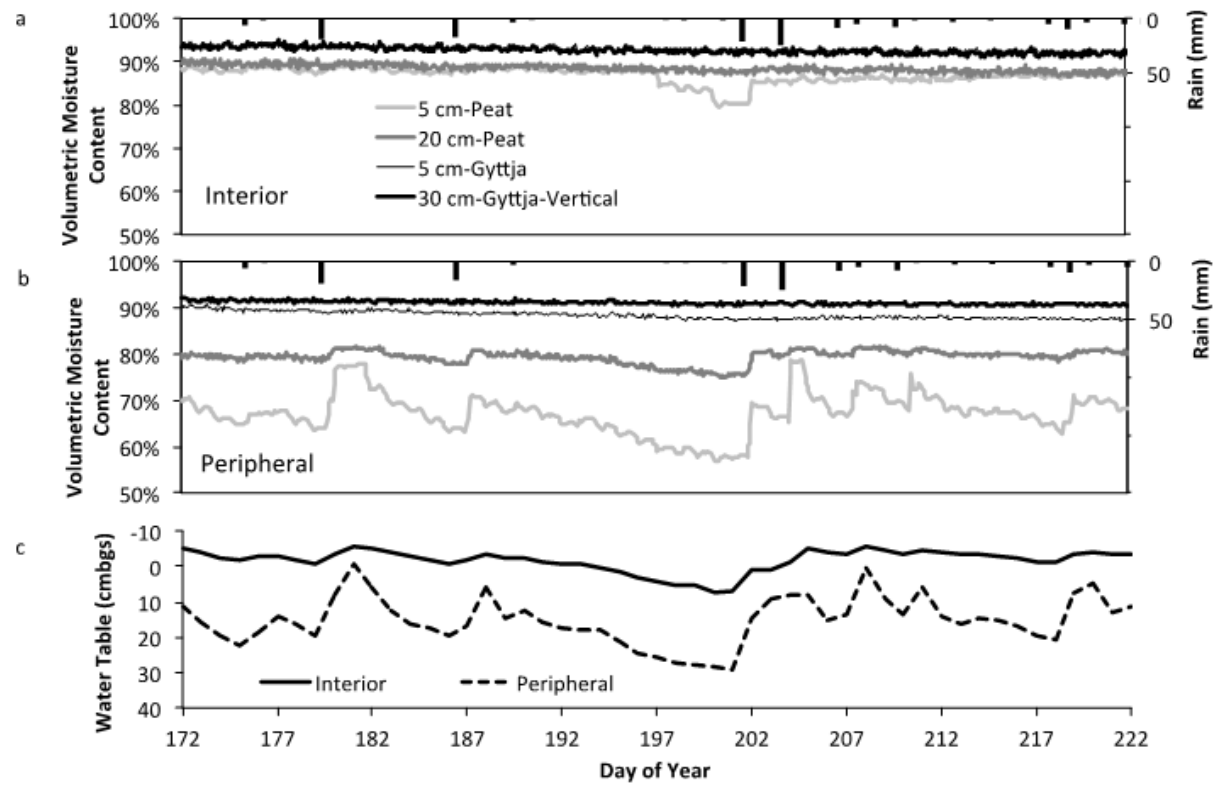
Figure 2. Volumetric moisture content and water table for interior and peripheral